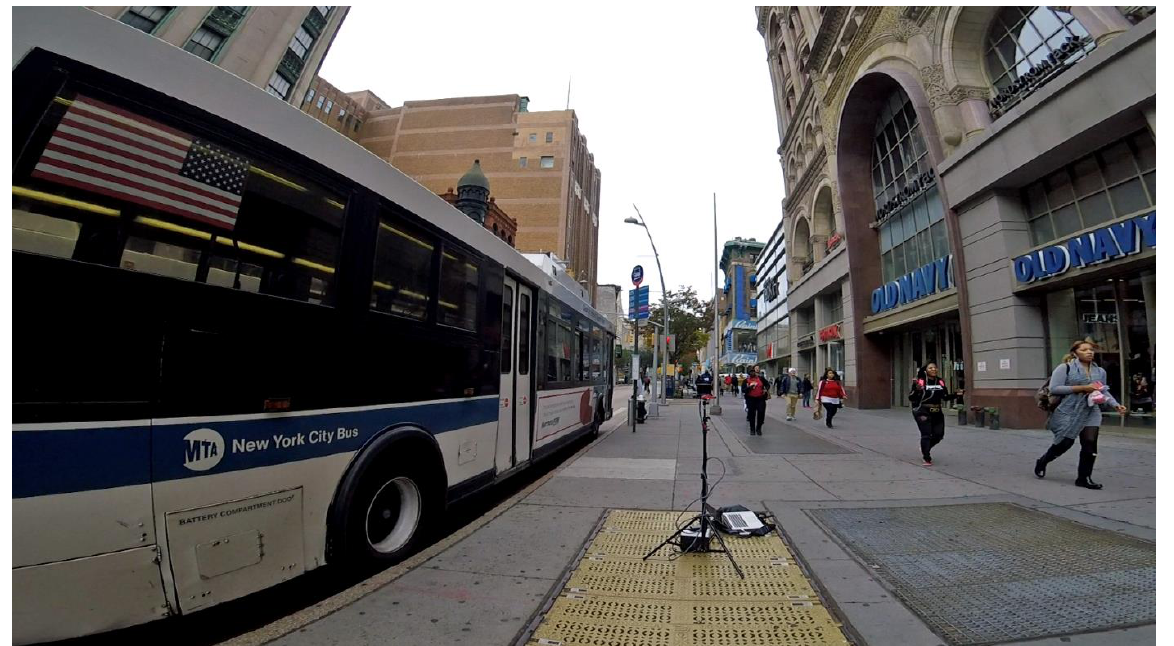
Figure 4. Automated analysis of pedestrian footfall on a retail high street with a LiDAR sensor positioned in the midst of high street dynamics.